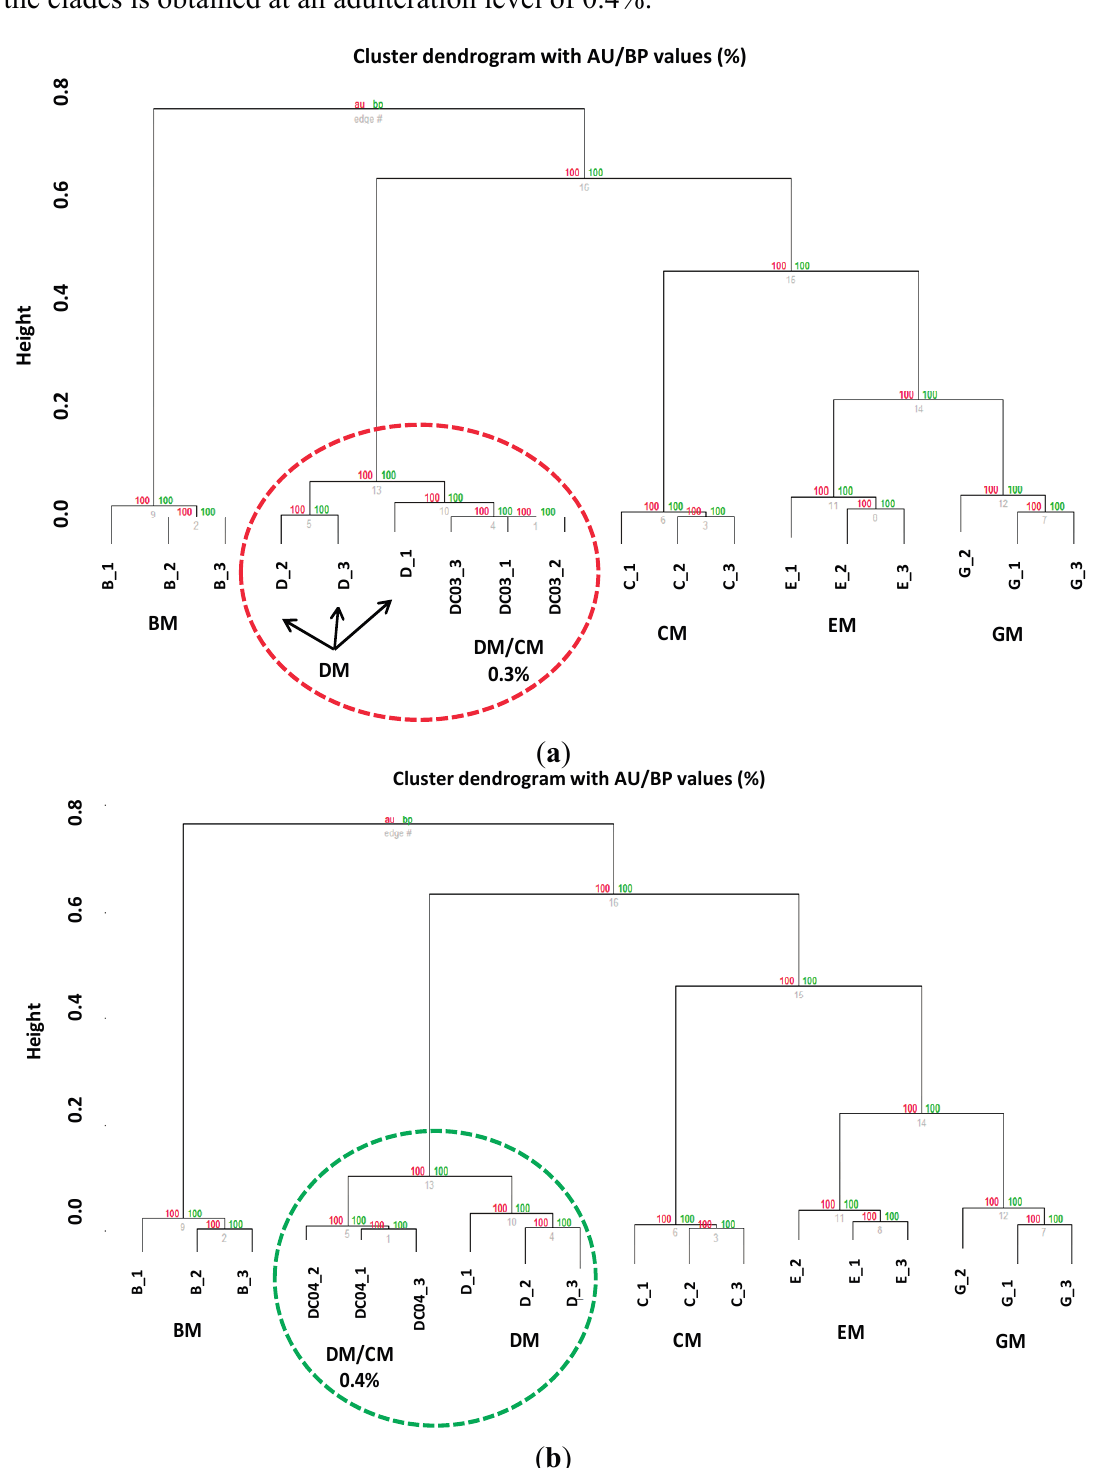
Figure 9. Hierarchical clustering tree of ( a ) adulterated DM with CM (0.3% v / v ) and ( b ) DM with CM (0.4% v / v ). Red circle indicates that the classification did not allow to obtain separate clades, whereas the green circle indicates that a good separation of the clades is obtained at an adulteration level of